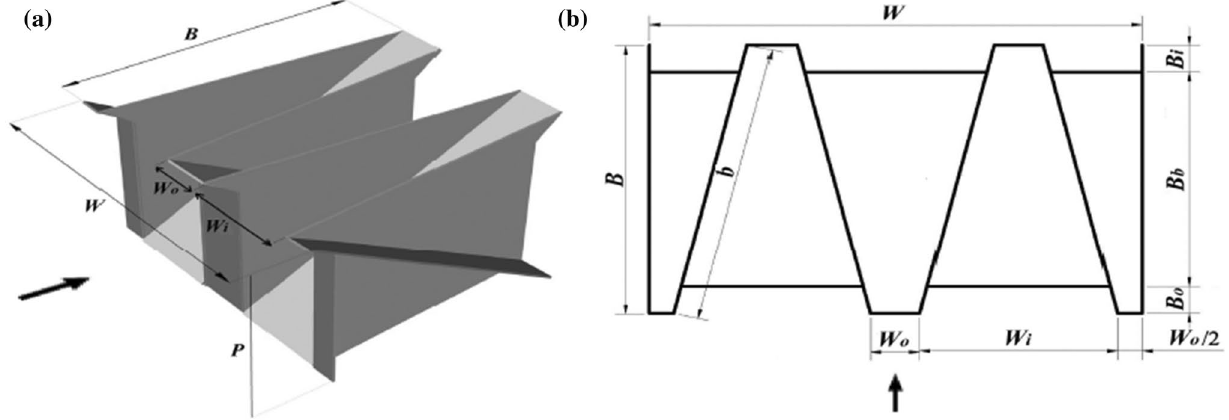
Fig. 2 General view of geometrical dimensions of trapezoidal PKW (Mehboudi et al. 2017)